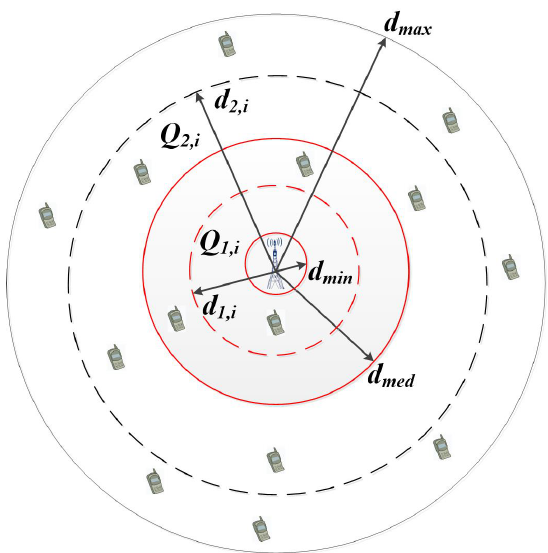
Figure 4. An illustration of dynamic user